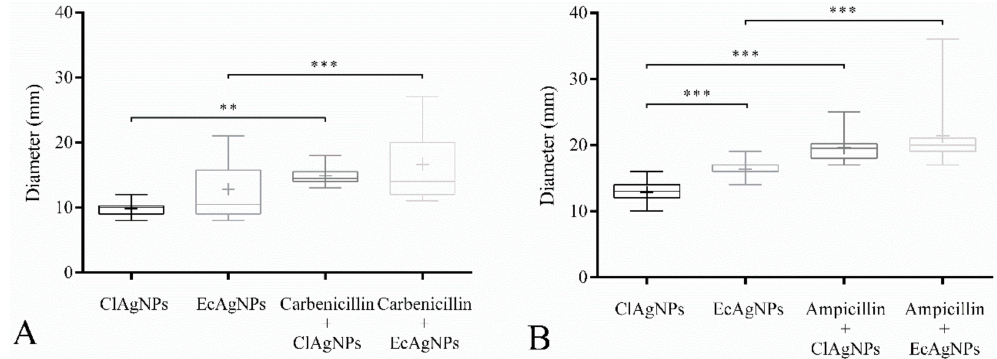
Figure 4. Disk Di ff usion Assay. E ff ect of NPs used alone and in synergistic combination with ( A ) carbenicillin against P. aeruginosa and ( B ) ampicillin against S. pseudintermedius . Statistical analysis showed di ff erences between inhibition halos of silver nanoparticles alone and those of silver in combination with carbenicillin and ampicillin. In S. pseudintermedius strains, EcAgNPs have a larger antibacterial e ff ect compared to ClAgNPs. Results are presented as mean ± SD (* p value: 0.05–0.01; ** p value: < 0.01; *** p value: <